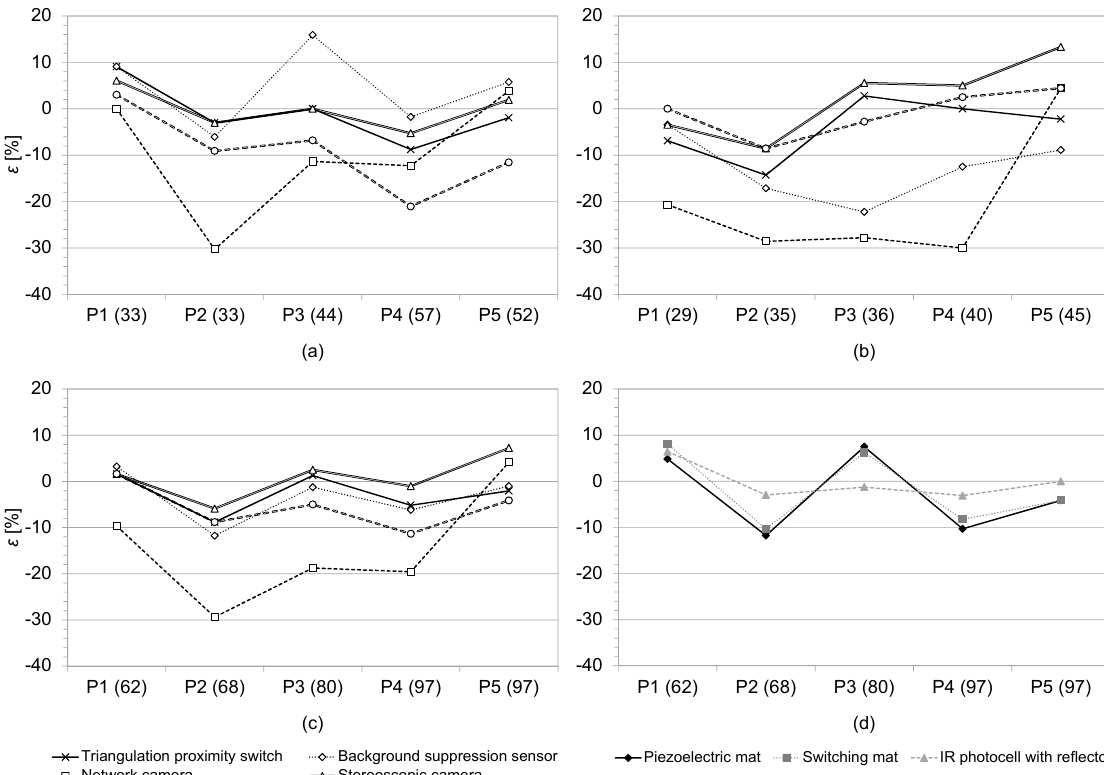
the counting direction for ( c ) the direction sensitive sensors and ( d ) the direction manual readings are presented in brackets.